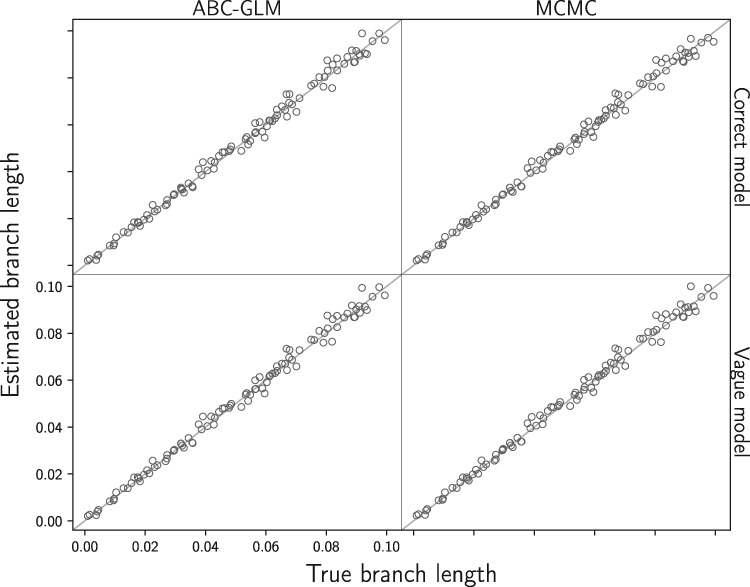
A comparison of the true branch length separating each pair of simulated sequences to the branch length estimated by ABC-GLM and full-likelihood MCMC under the correct branch-length model (branch length \documentclass[12pt]{minimal}
\usepackage{amsmath}
\usepackage{wasysym}
\usepackage{amsfonts}
\usepackage{amssymb}
\usepackage{amsbsy}
\usepackage{upgreek}
\usepackage{mathrsfs}
\setlength{\oddsidemargin}{-69pt}
\begin{document}
}{}$\sim$\end{document} uniform(0.0001, 0.1)) and the vague model (branch length \documentclass[12pt]{minimal}
\usepackage{amsmath}
\usepackage{wasysym}
\usepackage{amsfonts}
\usepackage{amssymb}
\usepackage{amsbsy}
\usepackage{upgreek}
\usepackage{mathrsfs}
\setlength{\oddsidemargin}{-69pt}
\begin{document}
}{}$\sim$\end{document} uniform(0.0001, 0.1)).